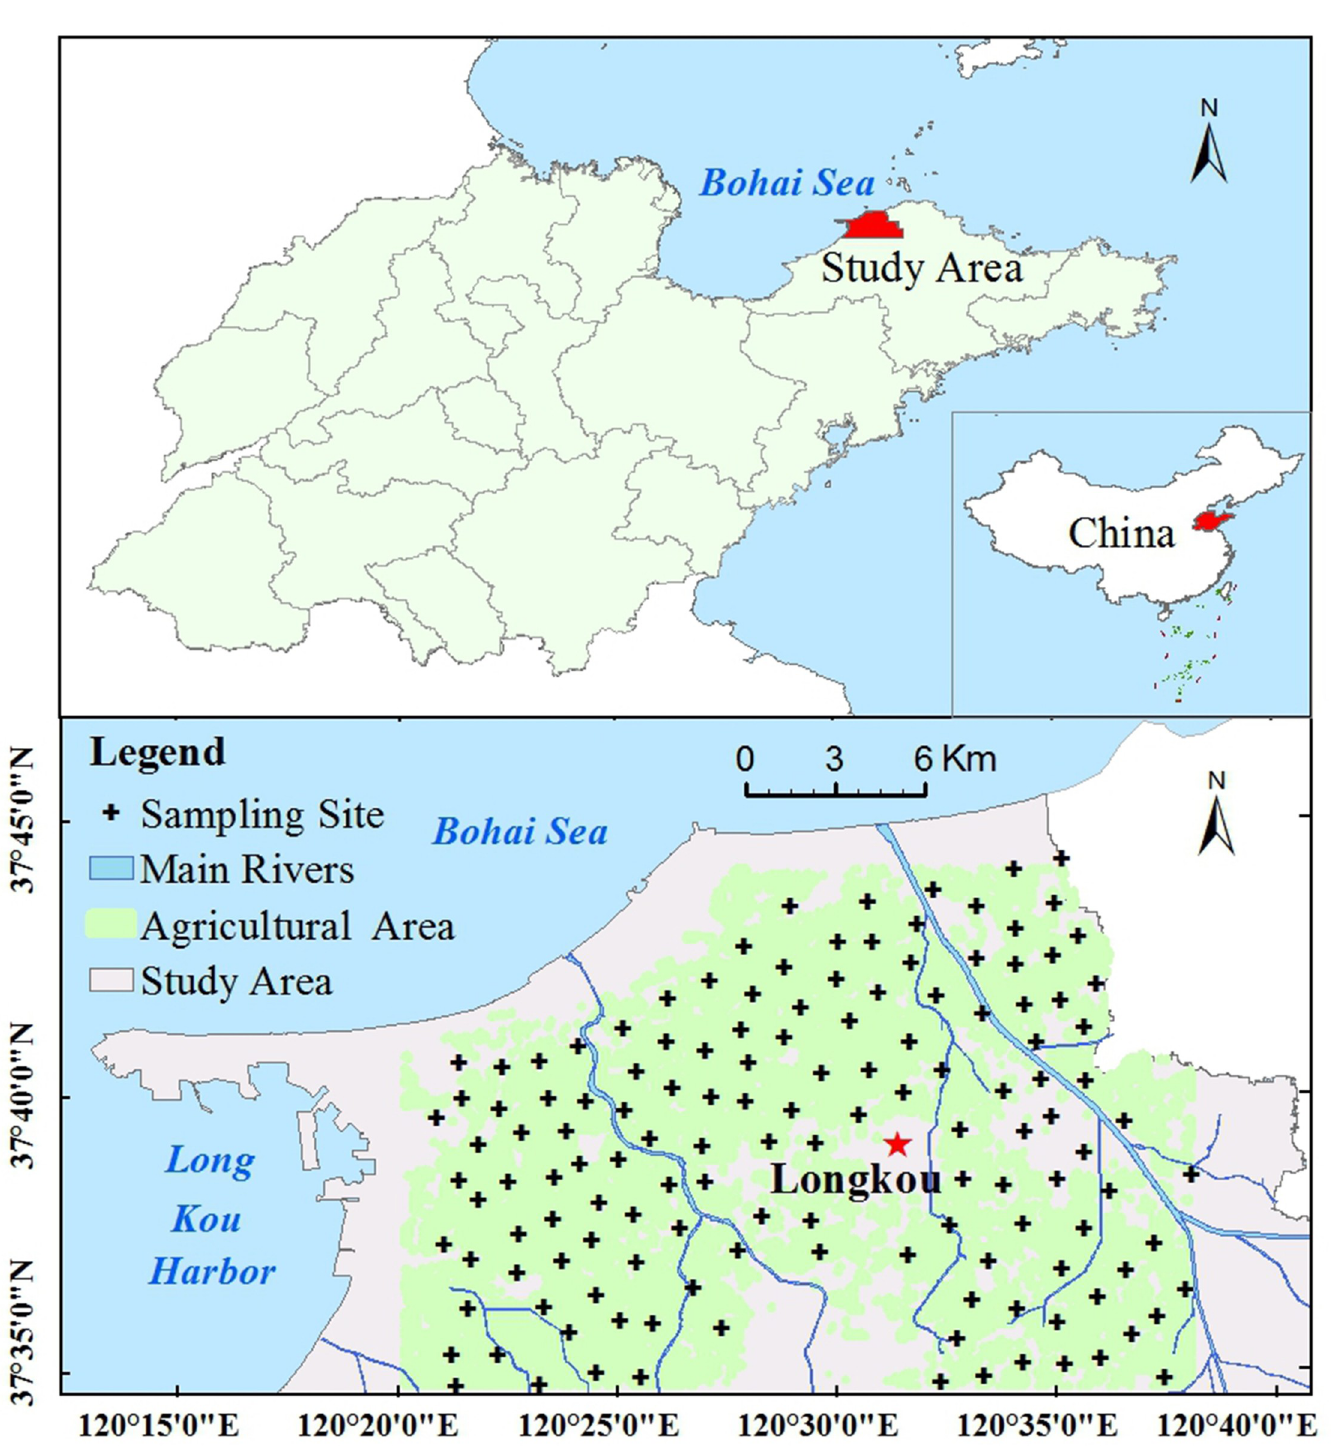
Fig 1. Geographical location of the study area with sampling sites. (The map was generated using free, open access data sources from the National Geomatics Center of China).